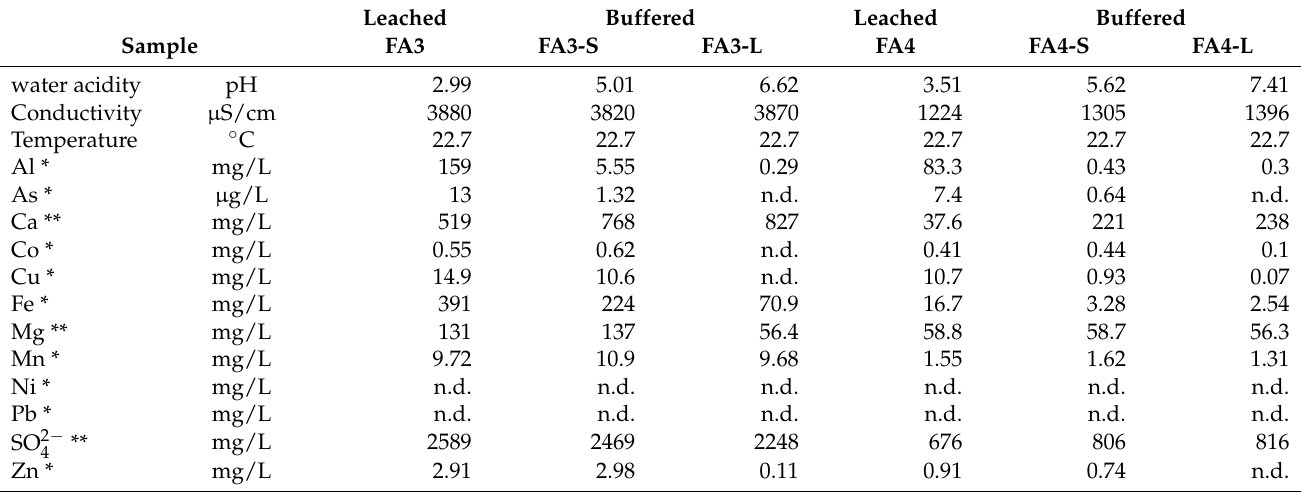
Table 4. Chemical–physical parameters and metal contents in leachates, before buffering (FA3 and FA4 liquid samples) and in short and long buffered solutions (FA3-S, FA3-L, FA4-S and FA4-L liquid samples). Two different methods of metal content analysis were used, ICP-MS (indicated with *) and chromatography (indicated with